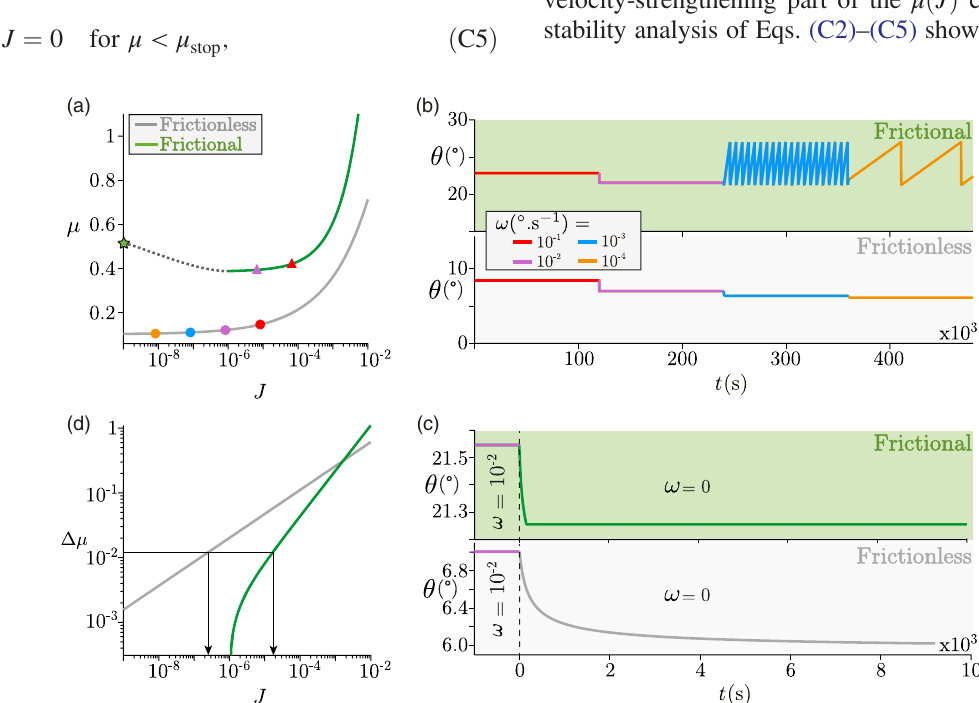
FIG. 8. Prediction of the avalanche model in the rotating drum. (a) Rheologies for the frictionless [grey curve, Eq. (C3)] and frictional [green curve, Eq. (C4)] suspensions as deduced from the experiments. The symbols correspond to the steady states for the constant rotation rates given in panel (b). (b) Time evolution of the avalanche angle for decreasing steps of rotation rates. (c) Relaxation of the avalanche angle when the drum stops ( ω ¼ 0 ) at t ¼ 0 after a continuous rotation. (d) Reduced macroscopic friction coefficient Δ μ ¼ μ − μ Δ μ , the viscous number for the frictional suspension is higher than for 0 versus viscous number J showing that, for a given the frictionless suspension, thereby explaining the faster relaxations observed for the frictional